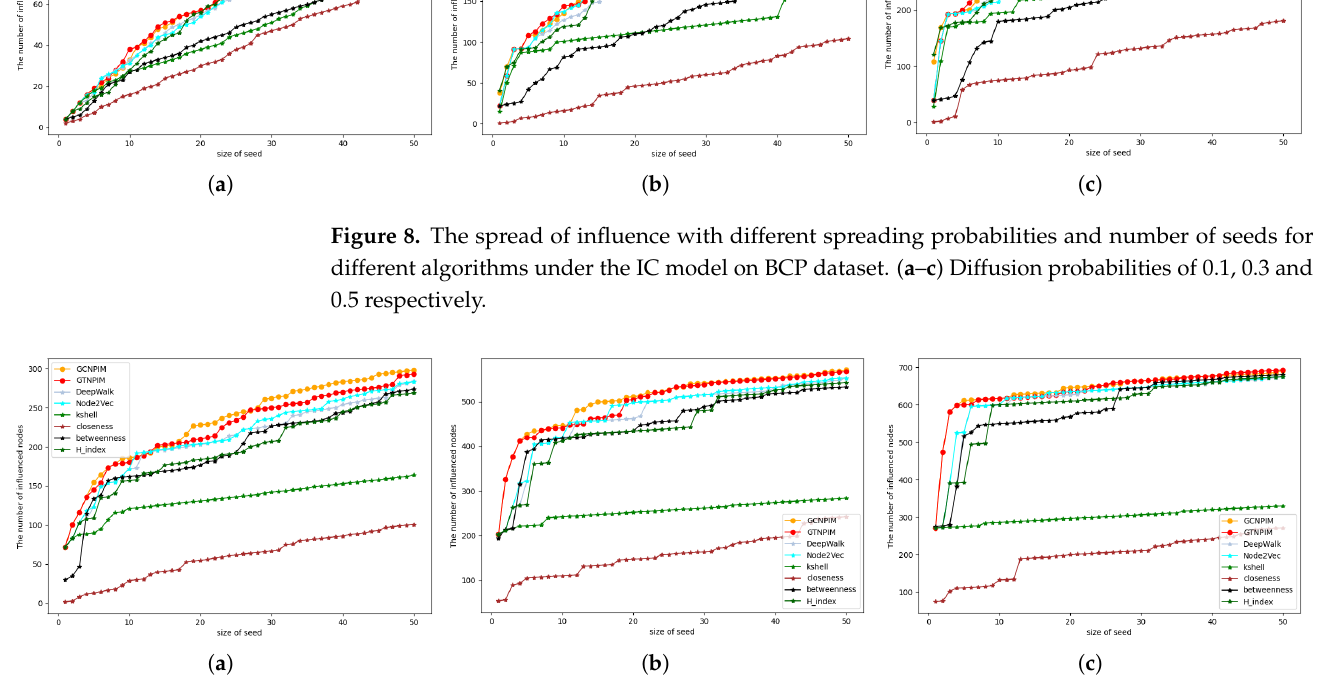
Figure 9. The spread of influence with different spreading probabilities and number of seeds for different algorithms under an IC model on MCP dataset. ( a – c ) Diffusion probabilities of 0.1, 0.3 and 0.5